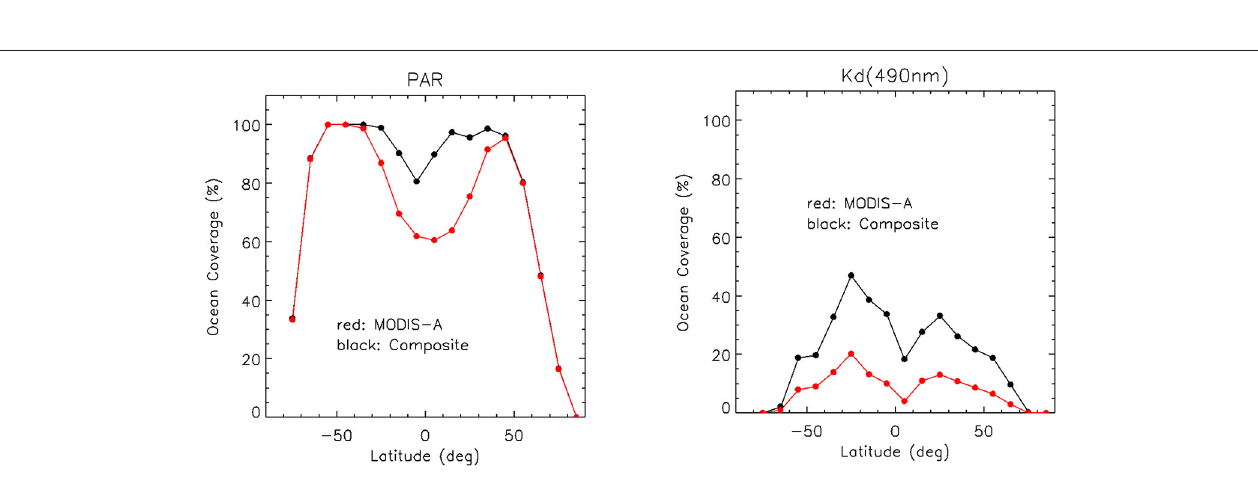
FIGURE 5 | Percentage of ocean coverage by daily PAR and K d products when using MODIS-Aqua data only (red curves) and combining MODIS-Aqua and -Terra data (black curves). Date is March 22, 2010. Coverage is almost total ( > 80%) in low to middle latitude regions for PAR (left) and at least doubled at most latitudes for K d (right) .